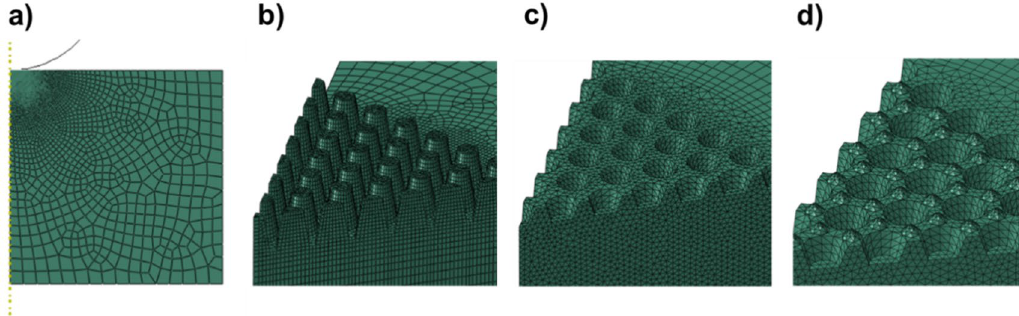
Figure 12. Simulated nanostructured surfaces: ( a ) flat surface, ( b ) moth-eye nanostructure ( c ) inverted nanocone with flat surface and ( d ) inverted nanocones including roughness and material pile-up at the